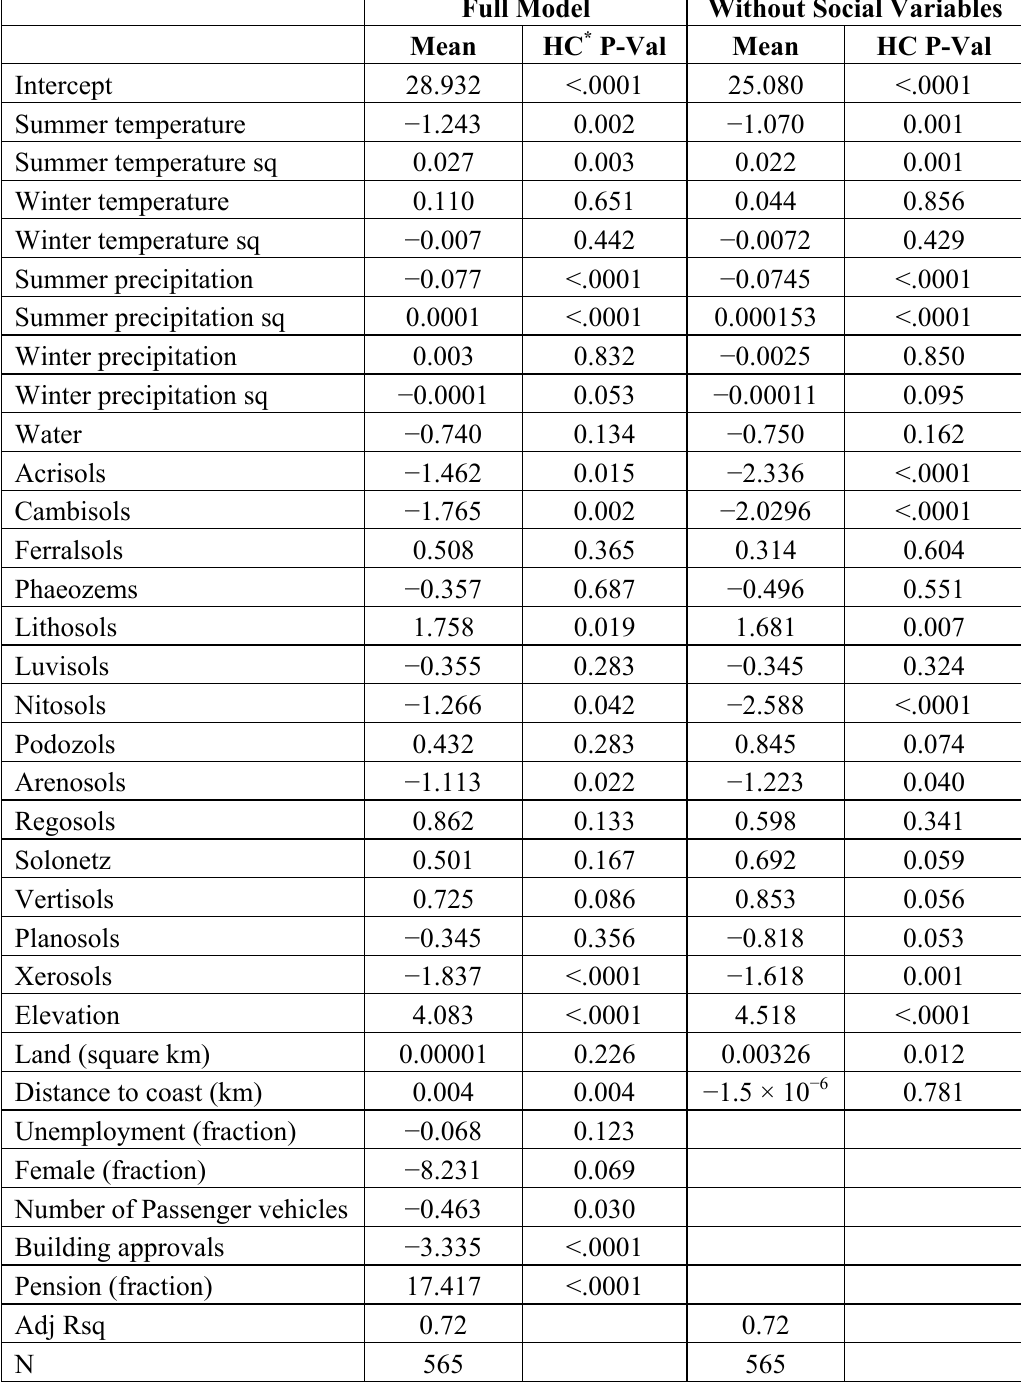
Table 2. The number of sheep (in log) per 1,000 rural